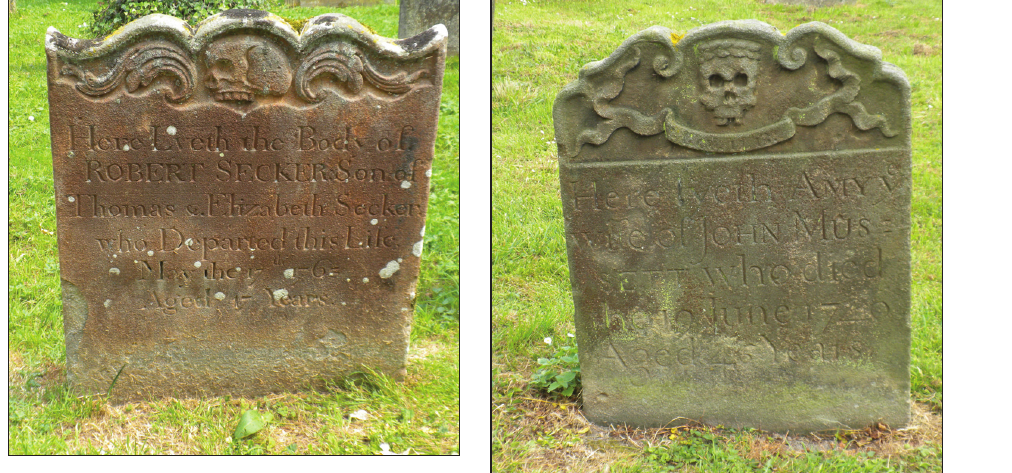
Figure 1: Tombstone showing partial fron- tal and side view of skull. St Margaret’s Church, Cley-next-the-Sea, Norfolk